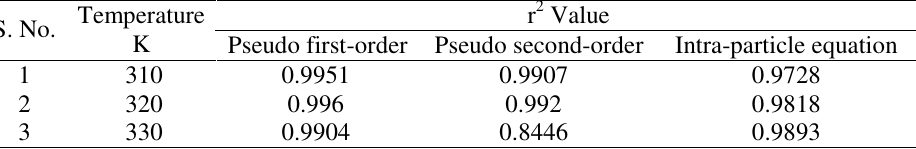
Figure 8 (c). Intra-particle diffusion equation. Figure 8. Plots of adsorption kinetic equations for adsorption of TBC onto NLP at different contact duration, (a) pseudo first-order equation, (b) the pseudo second-order equation and (c) the Intra-particle diffusion equation. Table 2. Kinetic parameters for the adsorption of CV onto